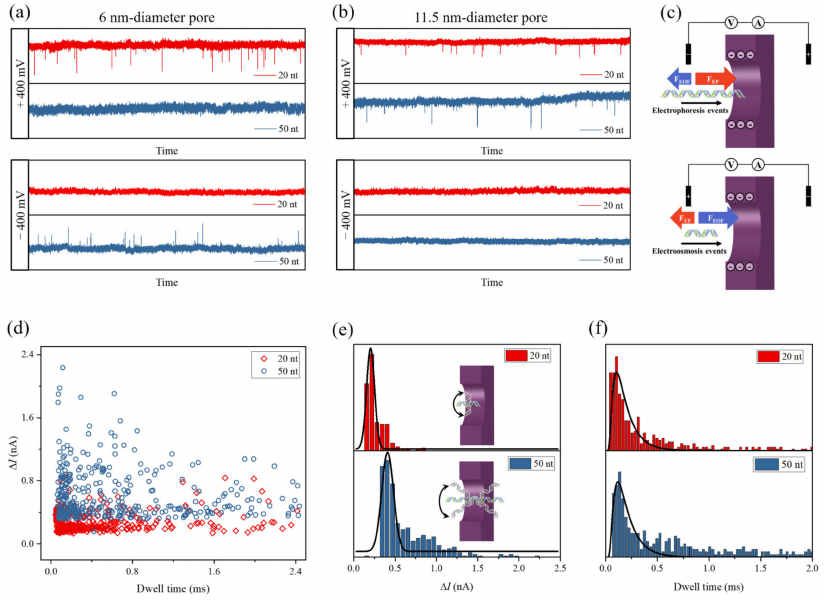
Figure 5. Ionic current traces with the translocations of 20 nt (red) and 50 nt (blue) ssDNA fragments through ( a ) 6 nm and ( b ) 11.5 nm diameter nanopores. The ssDNA fragments were added in the cis chamber filled with 1 M KCl solution. The applied voltage on the cis chamber was +400 or − 400 mV, and the trans chamber was electrically grounded; ( c ) schematic of an ssDNA transport through the pore, governed by the competition of F EO and F EP ; ( d ) scatter plot of dwell time versus current blockade for 20 nt and 50 nt ssDNAs electroosmotically transported through a 11.5 nm-diameter pore; ( e ) histograms of ∆ I for electroosmotic translocation events, which were fitted by Gaussian distribution; ( f ) histograms of dwell time for electroosmotic translocation events, which were fitted by first-passage-time